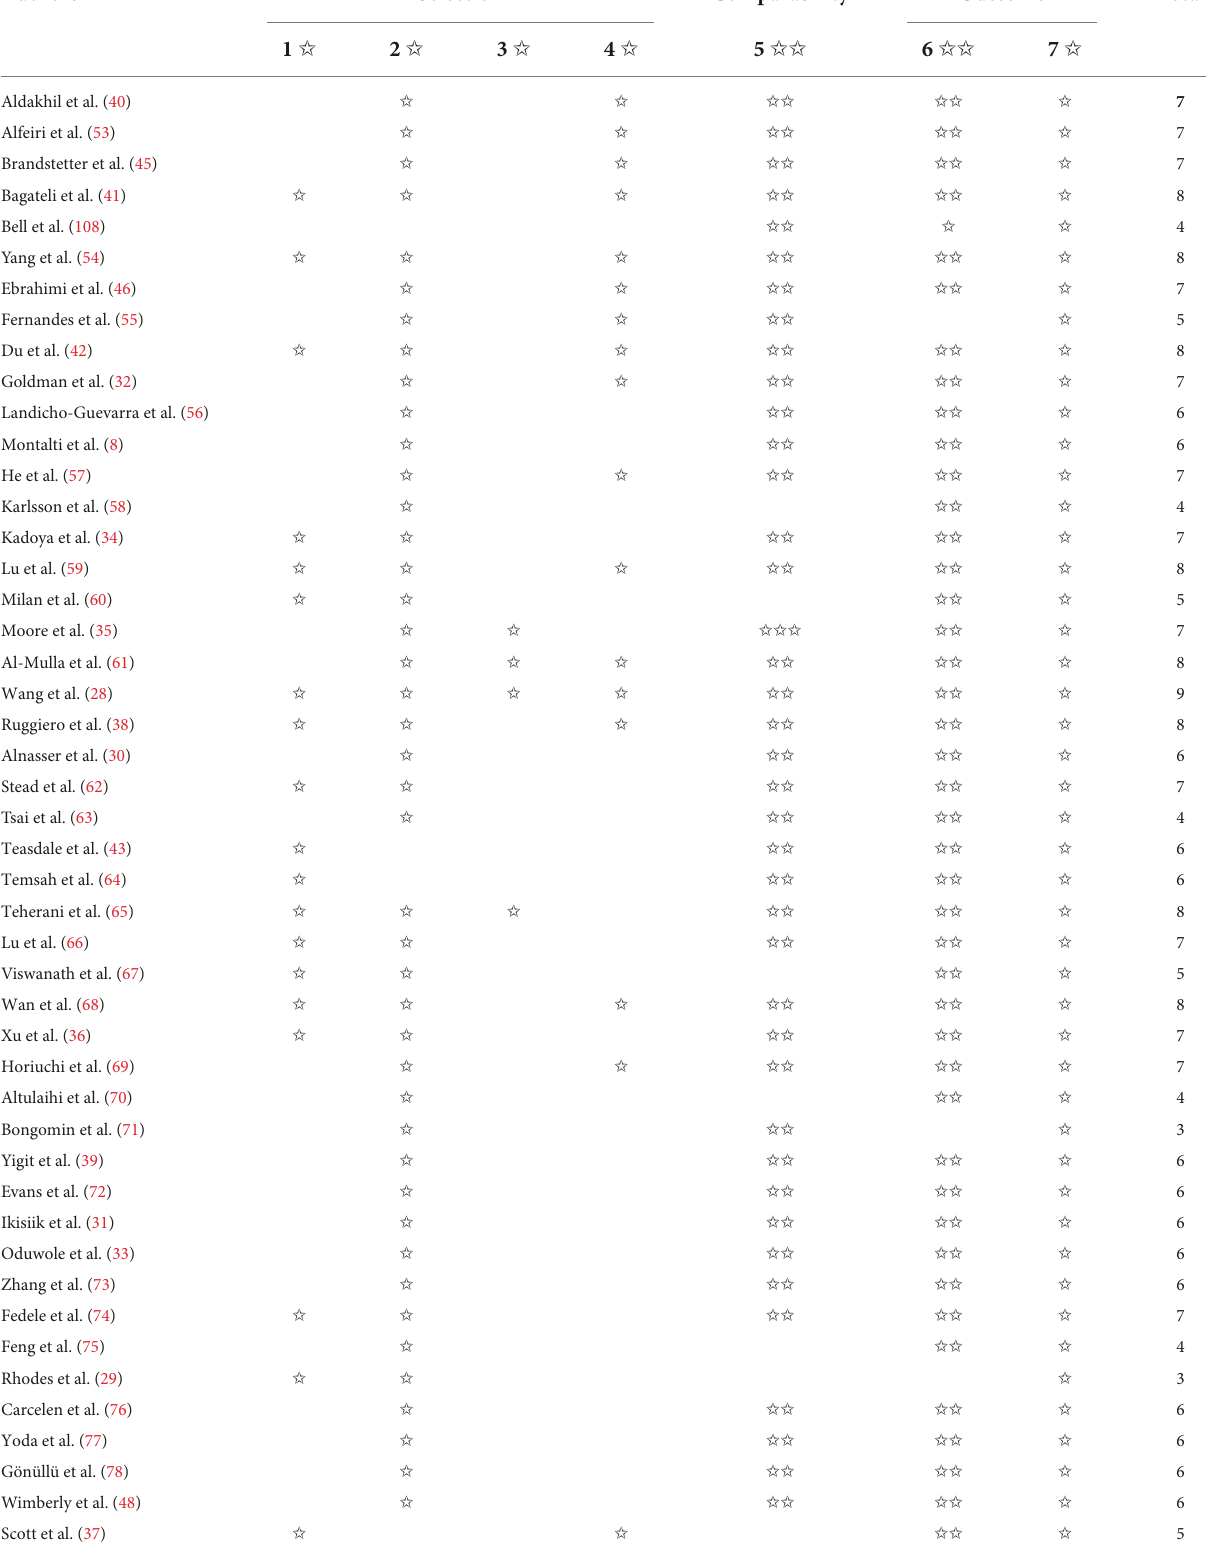
TABLE 4 Newcastle–Ottawa scoring for cross-sectional studies.